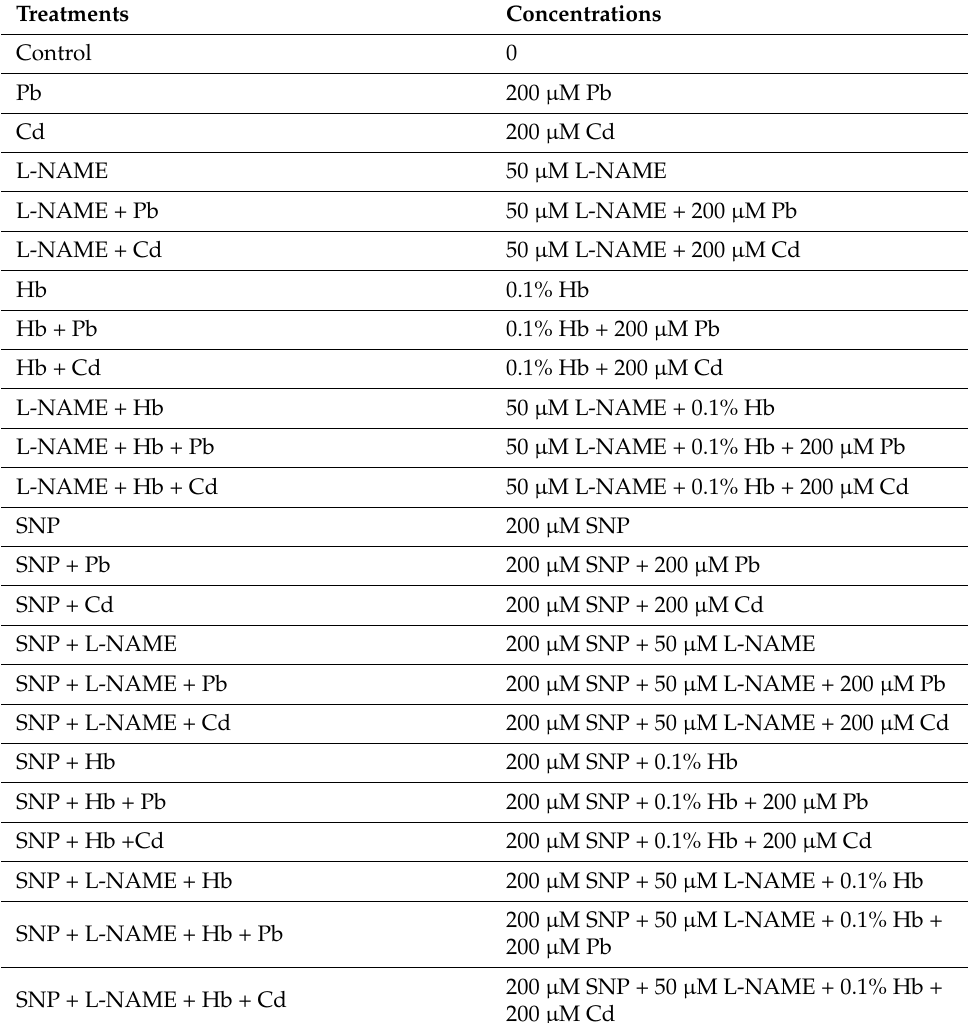
Table 1. The experimental